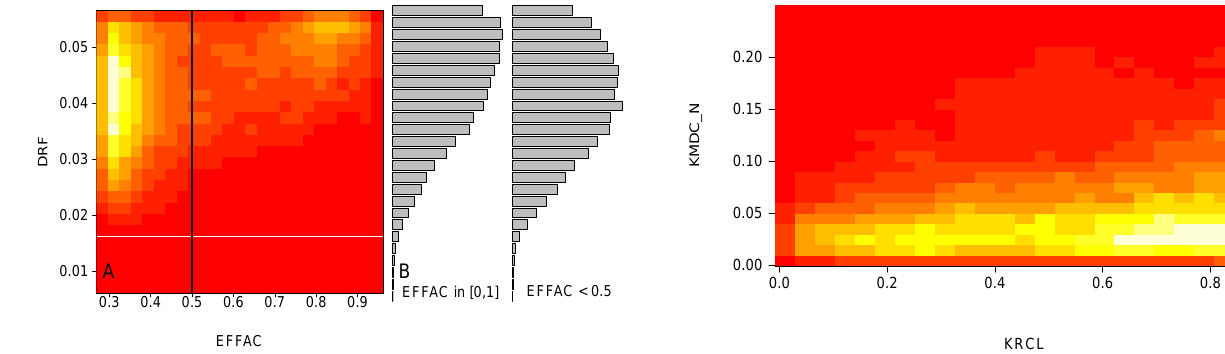
Fig. 3. Heat-map of 2-dimensional marginal distribution of KRCL (decomposition constant for labile litter pool) and KMDC N (fac- tor for half optimum content of nitrogen in soil solution for den- itrifier activity). Higher values of KRCL lead to a wider range of KMDC